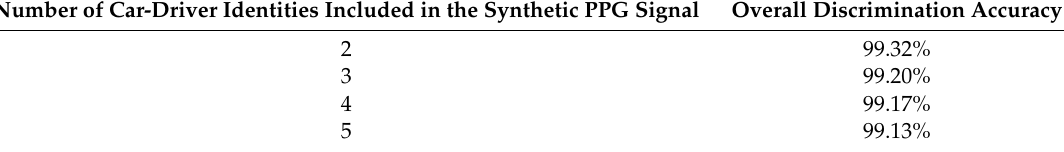
Table 3. Multiclass driver identity testing